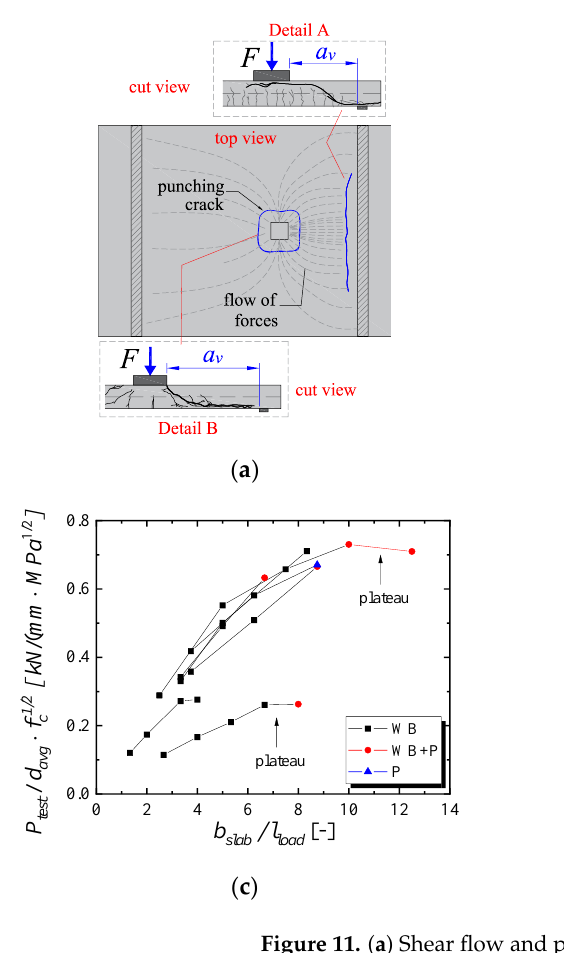
Figure 11. ( a ) Shear flow and possible shear failure mechanisms for the slab: one-way shear as wide beams, punching shear around the load and a mixed-failure mode; ( b ) sides enhanced or disturbed due to the ratio a v / d l and b slab / l load for a simply supported slab; ( c ) influence of the slab width to load size ratio b slab / l load on the failure load of slabs under concentrated loads (adapted from [24]); ( d ) influence of the slab width on the cracking pattern and consequently on the failure mechanism of the tests (adapted from Reiβen et al. [6 ]). Note: WB = wide-beam shear failure (one-way shear); P = punching failure; WB + P = mixed failure mode between one-way shear and punching shear.